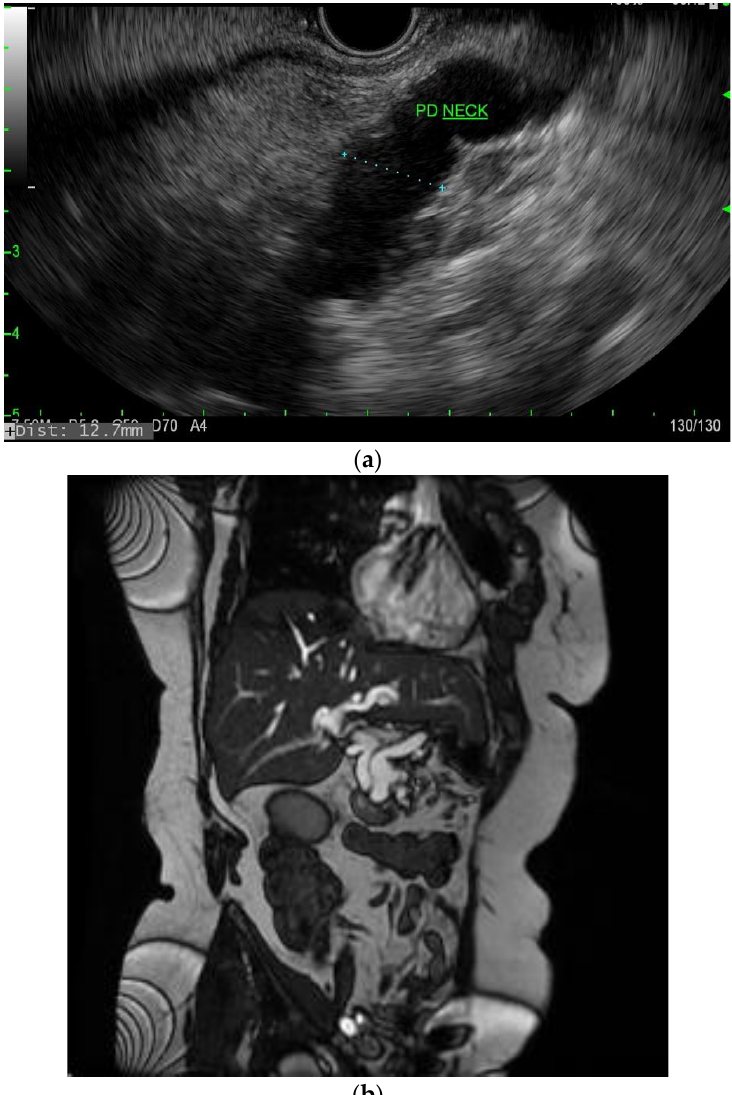
Figure 2. ( a ) EUS image of main duct IPMN; ( b ) MRI image of main duct IPMN.